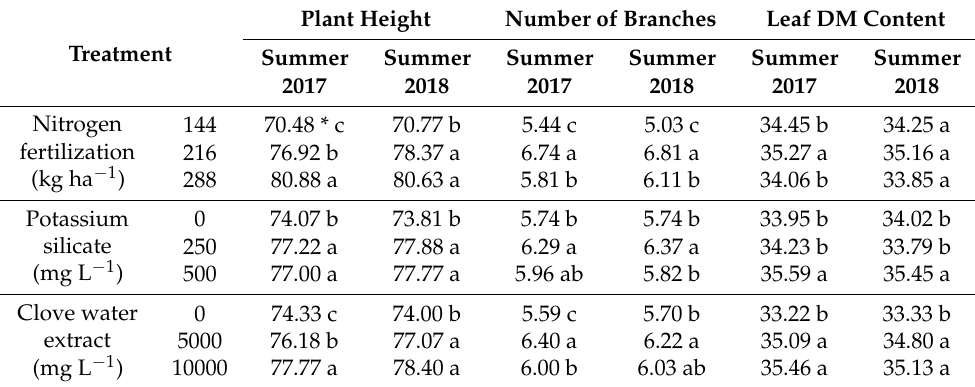
Table 2. Means of plant height (cm), number of branches per plant, and leaf dry matter content (g kg − 1 ) as affected by the nitrogen fertilization, potassium silicate and clove water extract main effects during 2017 and